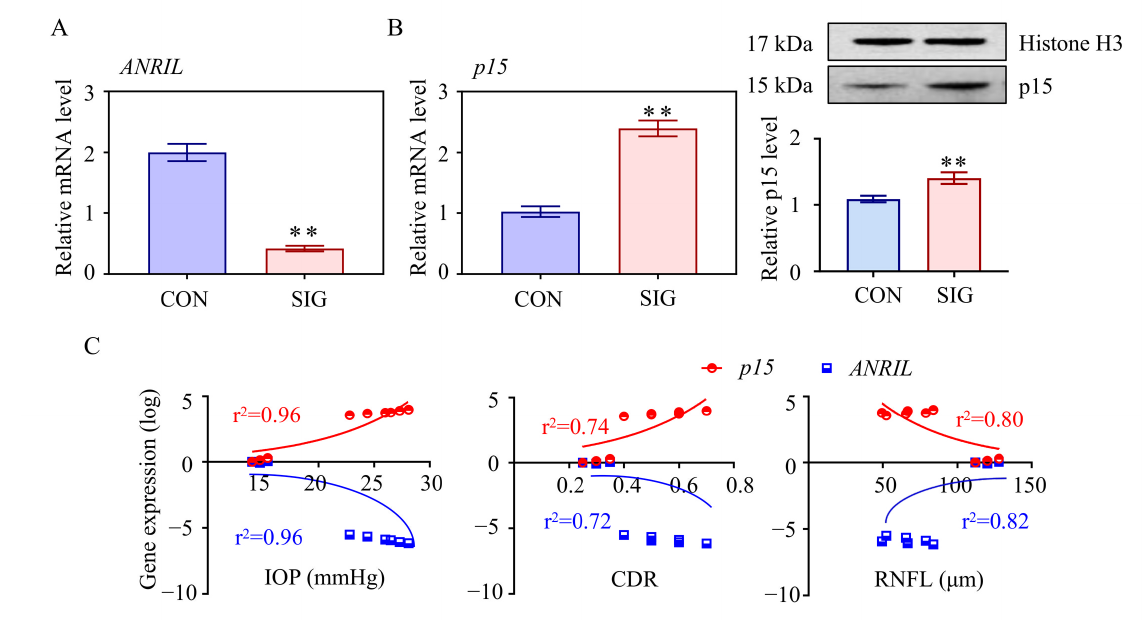
Figure 2. Essential role of ANRIL/p15 in SIG progression. The expression level of ANRIL and p15 in TM samples was measured in control and SIG groups. ( A ) lncRNA ANRIL decreased in SIG TM samples as measured by real-time PCR. ( B ) Increases in p15 were shown in SIG samples by Western blot. ( C ) The correlation between the expression level of ANRIL/p15 and ocular manifestations (IOP, CDR, and RNFL) was presented (r 2 values were calculated from Pearson’s method, all p < 0.05). Notes: n = 5 per group; CON = control; SIG = steroid-induced glaucoma; IOP = intraocular pressure; CDR = cup disc ratio; RNFL = retinal nerve fiber layer; ** p < 0.01 compared with control